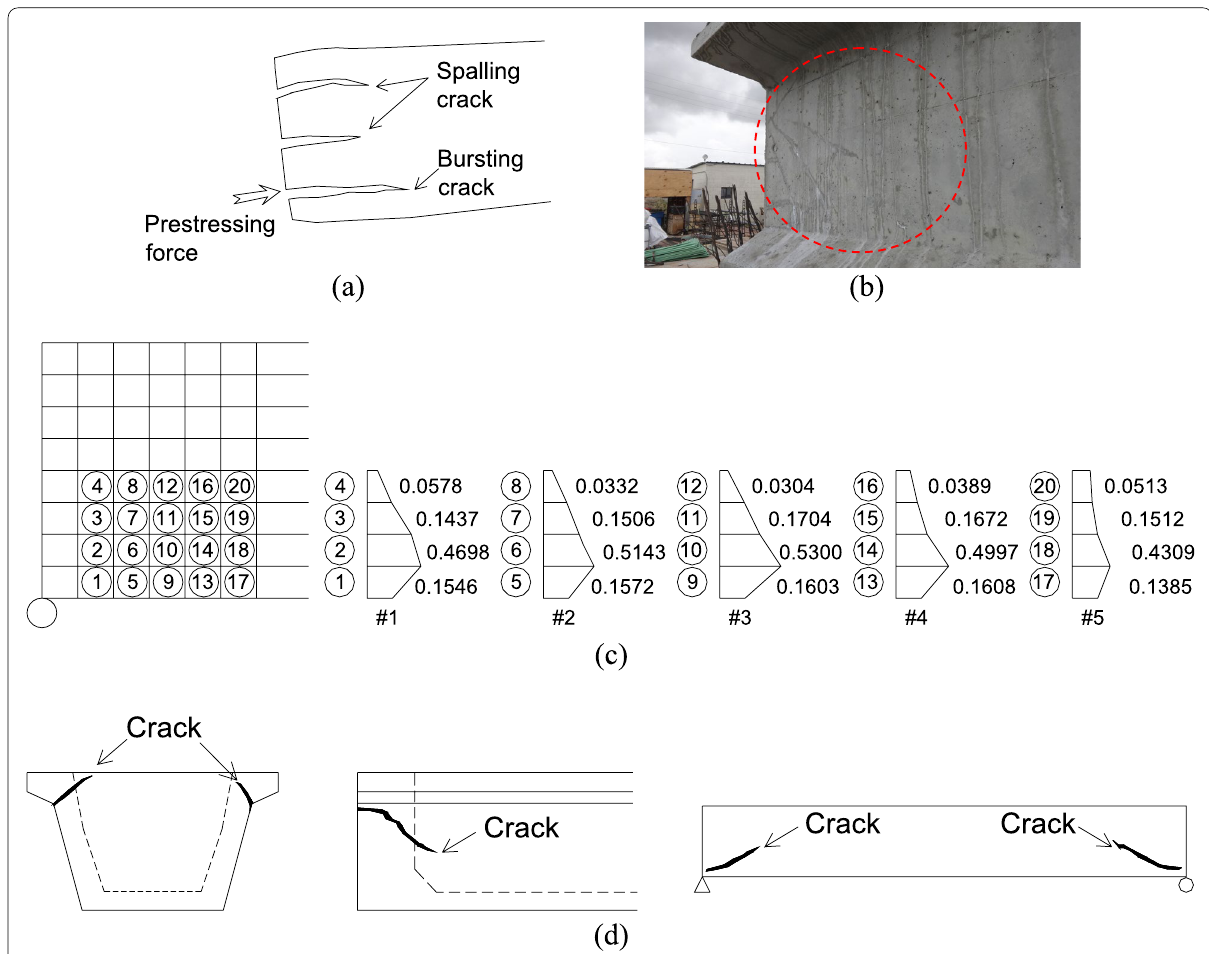
Fig. 6 Bursting and spalling at end-region of prestressed concrete girder (reproduced from Barrios [58]; Huang and Shahway [10]; photo courtesy Y.J. Kim): a crack type; b occurrence; c Stress distribution in end-region; d short-term and web cracking during